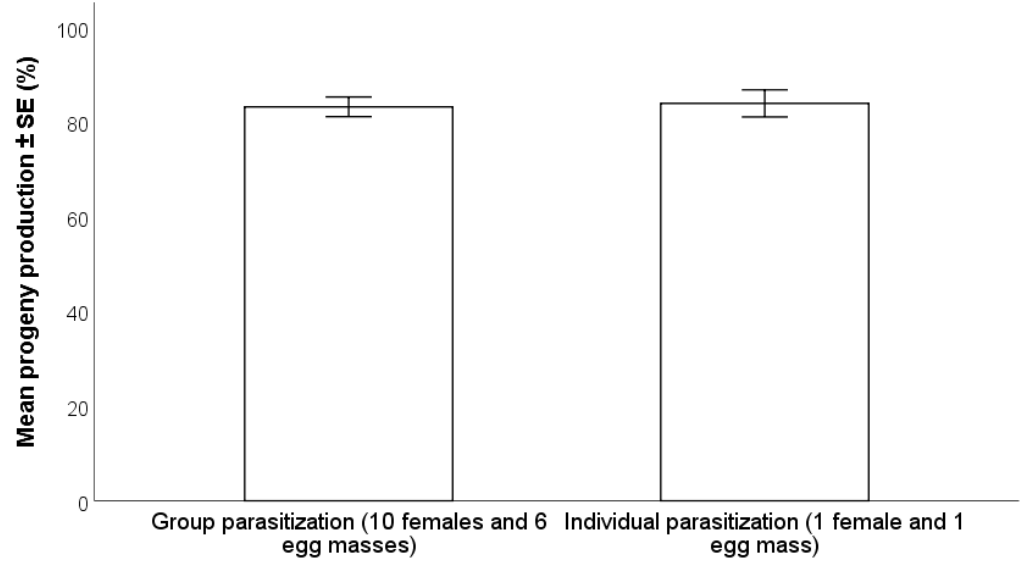
Figure 3. Effect of number of female: egg mass ( − 24 °C for 98 days) ratio on the production of progeny by Trissolcus japonicus (GLM, ( p > 0.05).